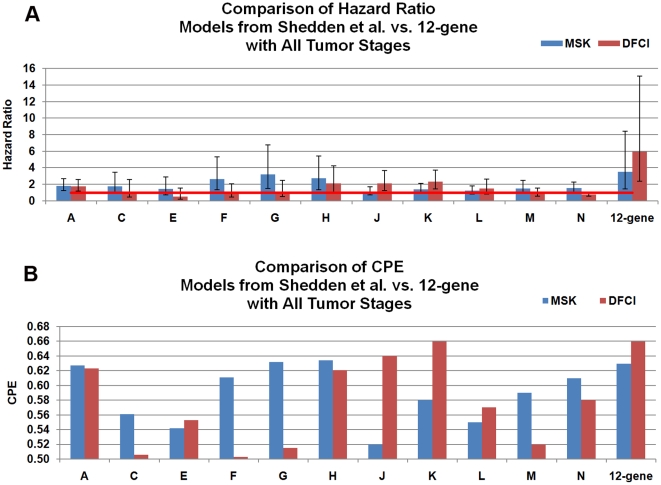
Comparison of the 12-gene risk score algorithm and various models presented by Shedden et al. [19] in two test sets in term of hazard ratios (A) and concordance probability estimate CPE (B).